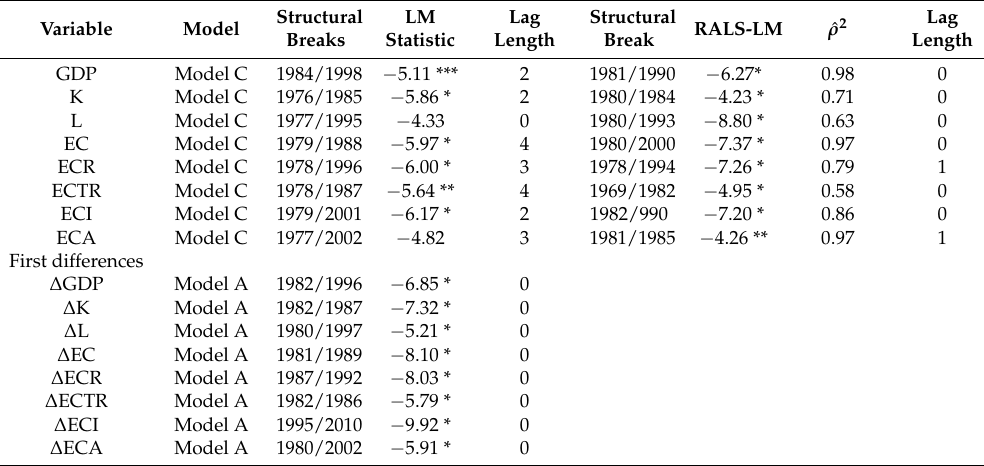
Table 3. Unit root tests with two structural breaks.